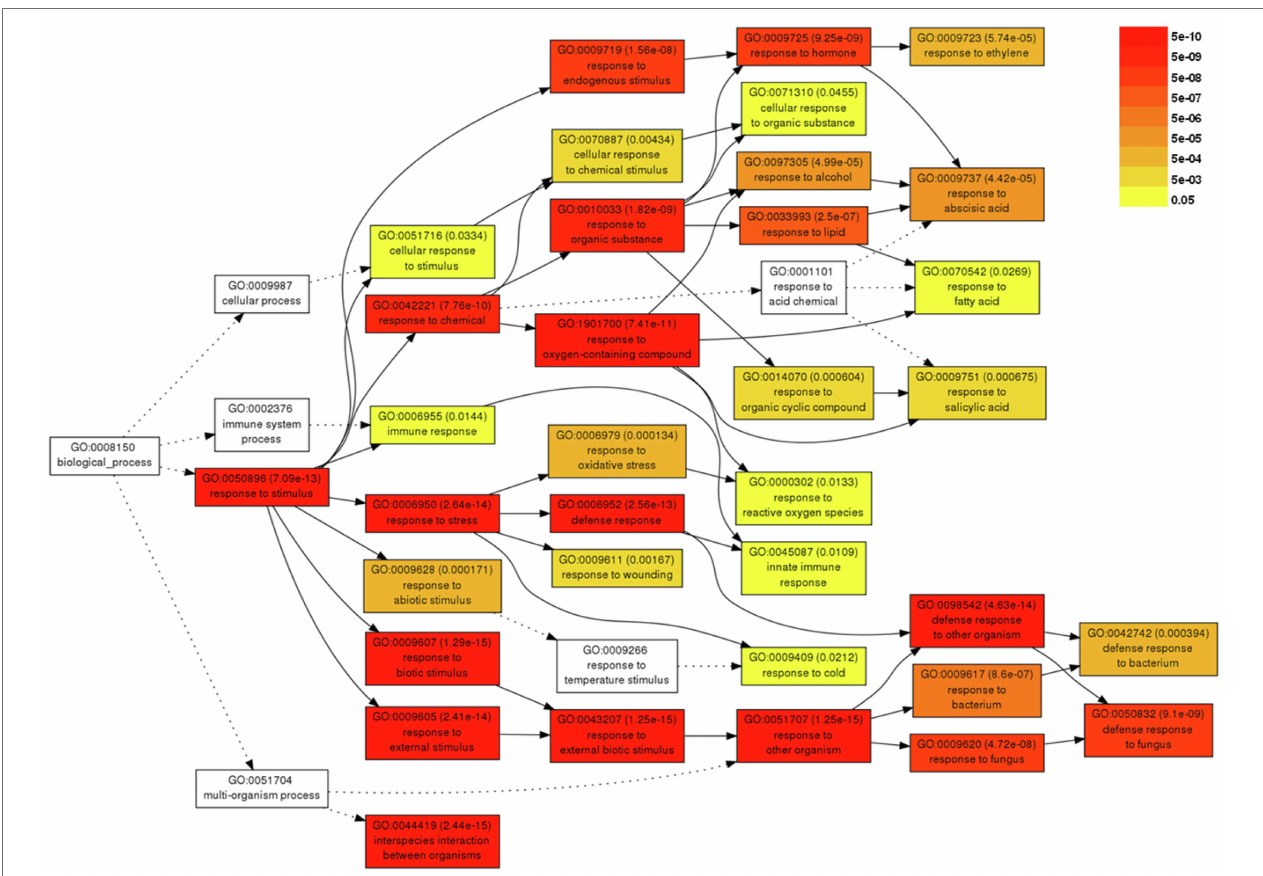
FIGURE 3 | Hierarchical tree graph of overrepresented gene ontology (GO) terms in response to BBWV2-PAP1. The graph was produced by singular enrichment analysis (SEA) using agriGO. Boxes in the graph represent GO terms labeled by GO number, statistical information, and term definition. The degree of color saturation in a box is proportional to the enrichment level of the term.